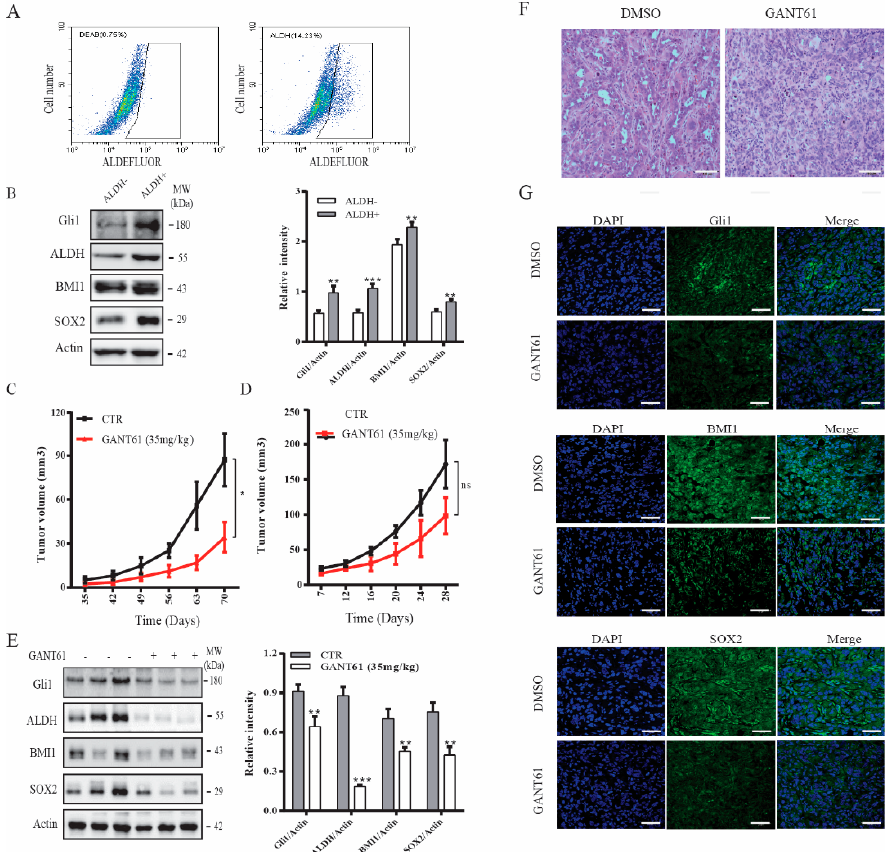
Figure 5. The Shh pathway promoted thyroid tumor development. ( A ) SW1736 cells were stained with ALDELUOR fluorescent dye and analyzed in flow cytometry. Diethylaminobenzaldehyde (DEAB), an inhibitor of ALDH, was added prior staining as a background control (left pane). ALDH-positive cells shown in the cropped area of the right panel and ALDH-negative cells (outside the cropped area) were collected separately. ( B ) Cell lysates prepared from ALDH-positive and ALDH-negative SW1736 cells sorted by flow cytometry in ( A ) were analyzed for BMI1, SOX2, Gli1 expression by Western blot. ( C ) ALDH-positive SW1736 cells (5 × 10 4 cells/mouse, 8 mice per group) were injected subcutaneously into NCG mice. One week later, the mice were treated with the corn oil vehicle or GANT61 (35 mg/kg/day) daily for two weeks by intraperitoneal injection. Tumor volumes were measured twice weekly for 10 weeks. ( D – F ) Unsorted SW1736 cells (1 × 10 6 cells/mouse, 8 mice per group) were injected subcutaneously into NCG mice. Three days later, mice were treated with the corn oil vehicle or GANT61 (35 mg/kg/day) daily for 3 weeks by intraperitoneal injection. Tumor volumes were calculated and statistically analyzed ( D ) Tumor tissues form mice were homogenized and analyzed for Gli1, BMI1, SOX2, and Actin expression by Western blot. The samples from three mice in the untreated or GANT61-treated groups are shown ( E ). Relative protein levels in the tumor tissues from all eight mice were analyzed by quantification of the density of the protein bands with NIH Image-J software and presented as bar graphs. * p < 0.05, ** p < 0.01, *** p < 0.001, ns: not significant. ( F ) The sections of paraffin-embedded tumor blocks from untreated or GANT61-treated mice were analyzed for histological appearance by H&E staining. Scale bar, 100 mm. ( G ) The frozen sections of tumor tissues from untreated or GANT61-treated mice were analyzed for BMI1, SOX2, and Gli1 expression by IF staining with their specific antibodies. Scale bar, 50